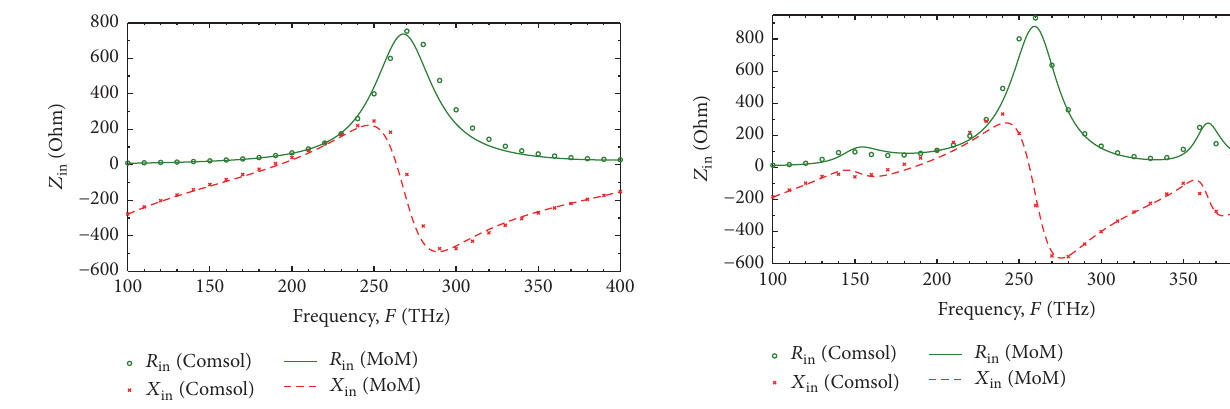
Figure 7: Input impedance of the composed nanoantenna as a function of frequency.